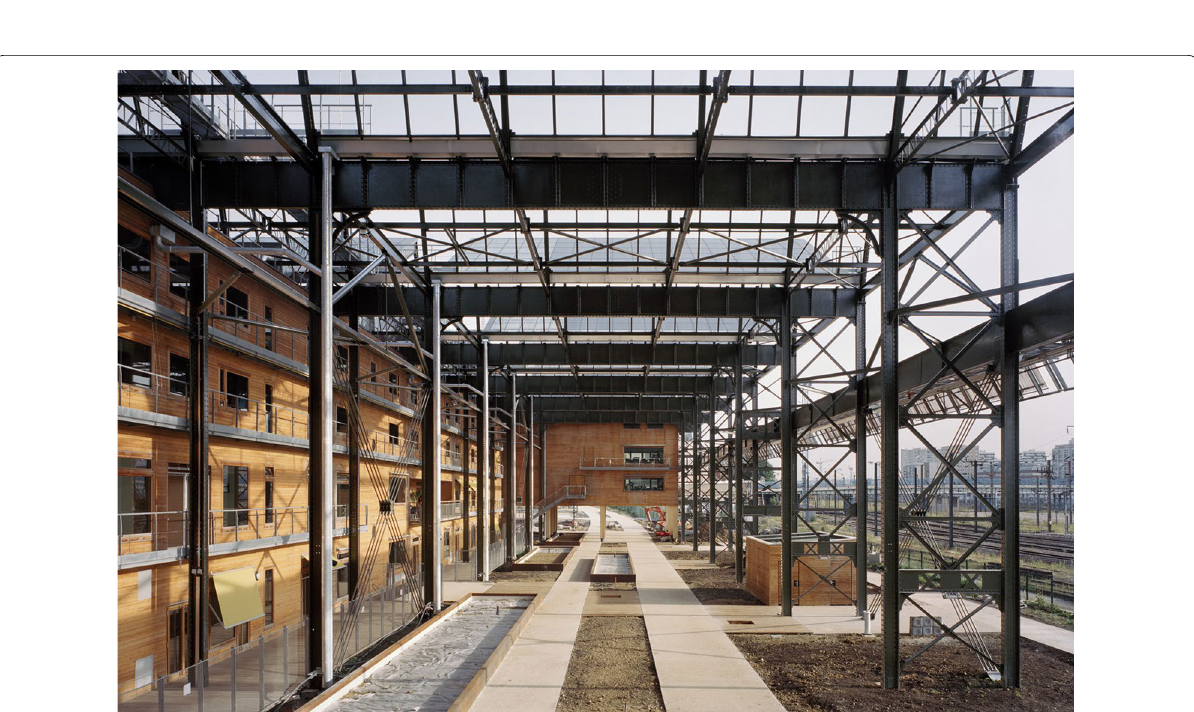
Fig. 27 Requalification of abandoned warehouse Halle Pajol in Paris with the inclusion of multiple public and private functions: the photovoltaic roof shelters also open spaces for orchards and common areas (from http://www.jourd a-archi tecte